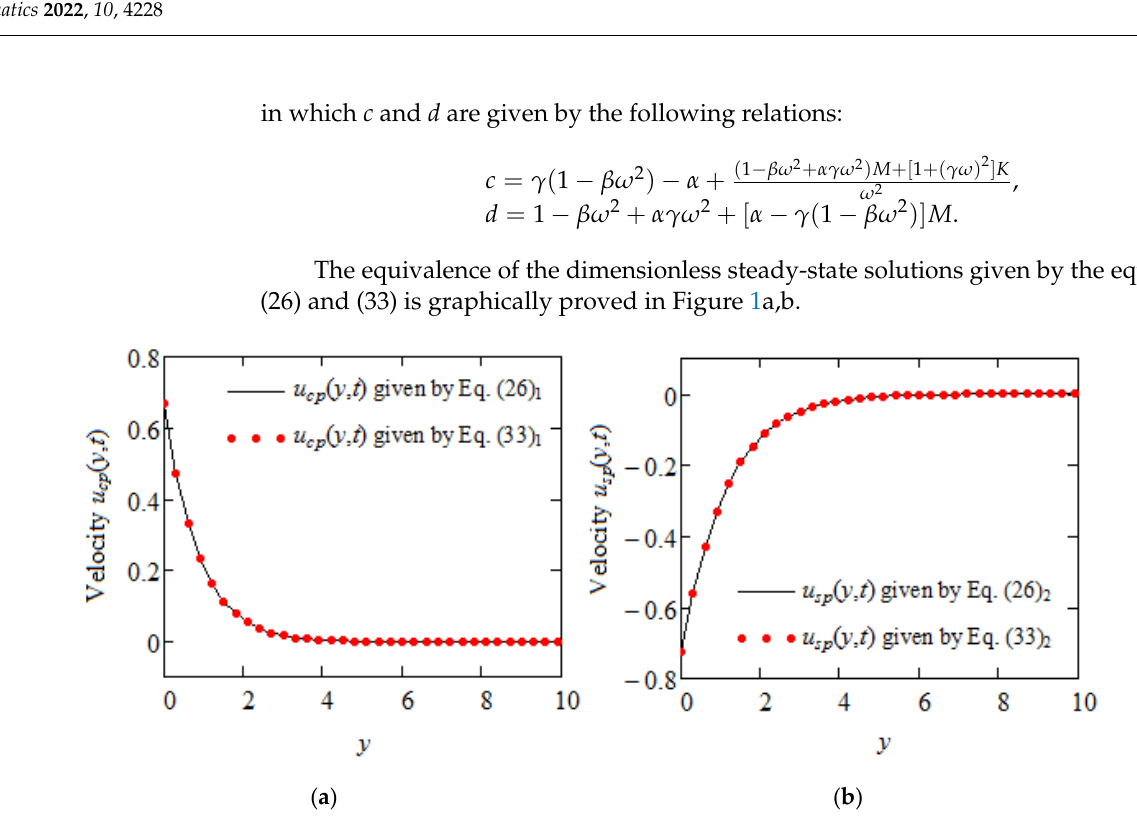
Figure 1. Equivalence of velocity fields u cp ( y , t ) and u sp ( y , t ) given by Equations (26) and (33) for α = 0.8, β = 0.7, γ = 0.6, ω = π /12, M = 0.6, K = 0.4, K ef f = 1, and t = 10. The dimensionless steady-state velocity fields u cp ( y , t ) and u sp ( y , t ) corresponding to isothermal motions of the same fluids in the absence of magnetic or porous effects can immediately be obtained by taking M = 0, respectively K = 0 in Equations (26) and (33), respectively. In the absence of both effects, when M = K = 0, the present solutions reduce to those obtained by Fetecau et al. [22] (Equations (19) and (20)). Moreover, the dimensionless steady-state solutions corresponding to incompressible Oldroyd-B, Maxwell, and Newtonian fluids that are performing similar motions are immediately obtained by taking β = 0, β = γ = 0 or α = β = γ = 0, respectively, in the previous relations. The dimensionless steady-state velocity fields corresponding to motions of the incompressible Newtonian fluids over an infinite flat plate that apply an oscillatory shear stress S cos ( ω t